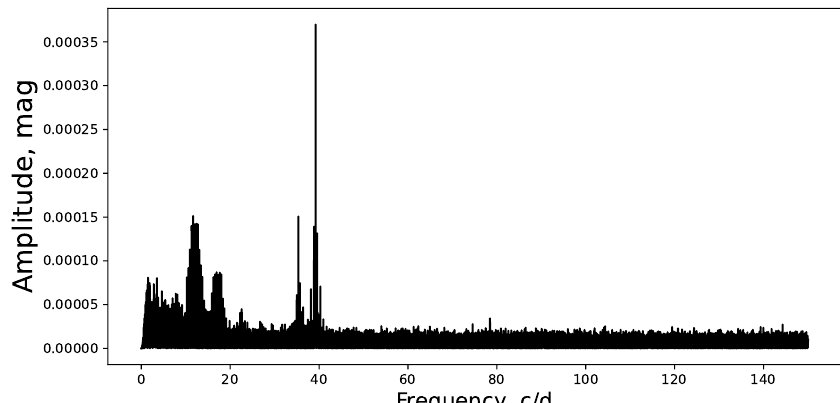
Figure 3. The discrete Fourier transform spectrum of the out-of-eclipse light curve of RR Dra, display- ing multiple frequency peaks. The peak at 39.22 c/d (corresponding to a period of 36.7 min) with an amplitude of 0.000369 mag is associated with the dominant oscillations of the primary component.